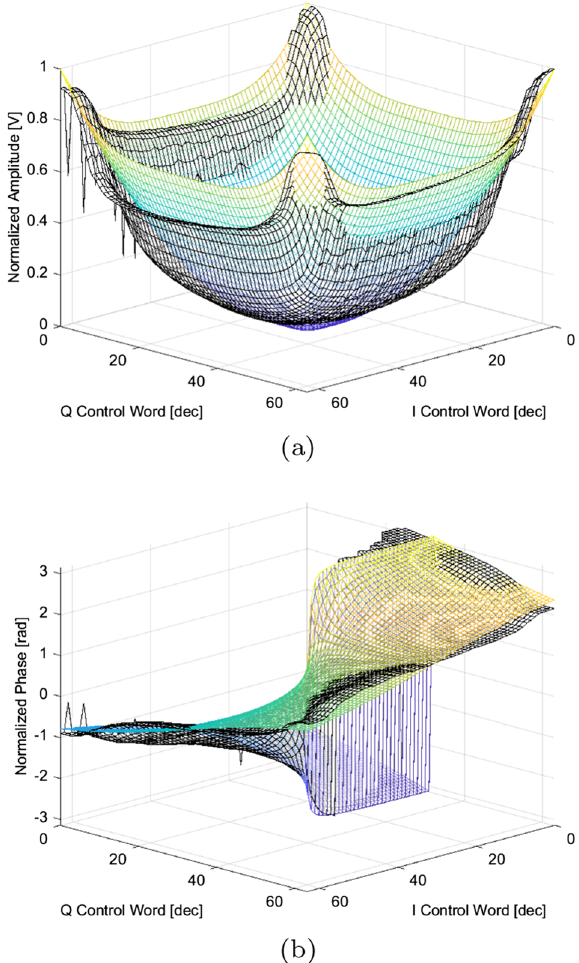
Fig. 3 Amplitude ( a ) and phase ( b ) as a function of all control word values. The colored surface is fitted data, and black is the measured